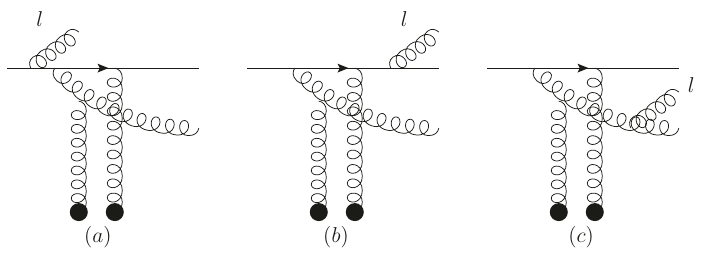
Figure 3 . Soft gluon ( l ) radiation diagrams. Diagrams with the soft gluon radiated from the incoming gluon leg do not produce large Sudakov logarithm.